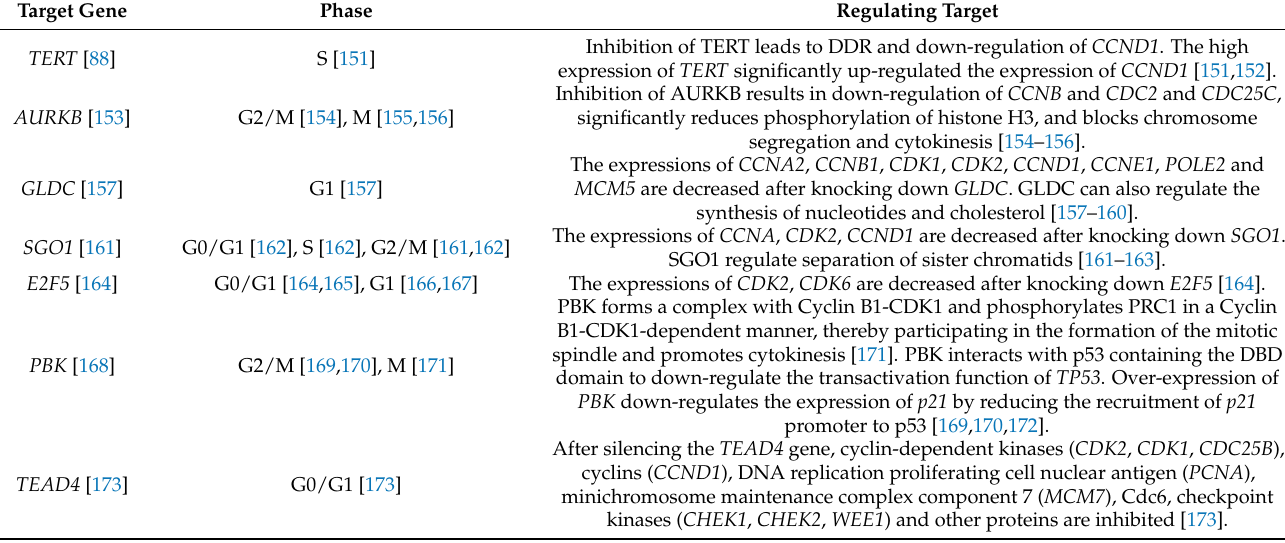
Table 1. Target genes up-regulated by N-Myc and their regulating targets. The seven target genes listed in the form show their ability to regulate the process of cell cycle in a relatively unspecific way. Up- or down-regulation of the expression of these MYCN target genes affects the expression of genes further downstream, but there is no direct evidence of the regulatory